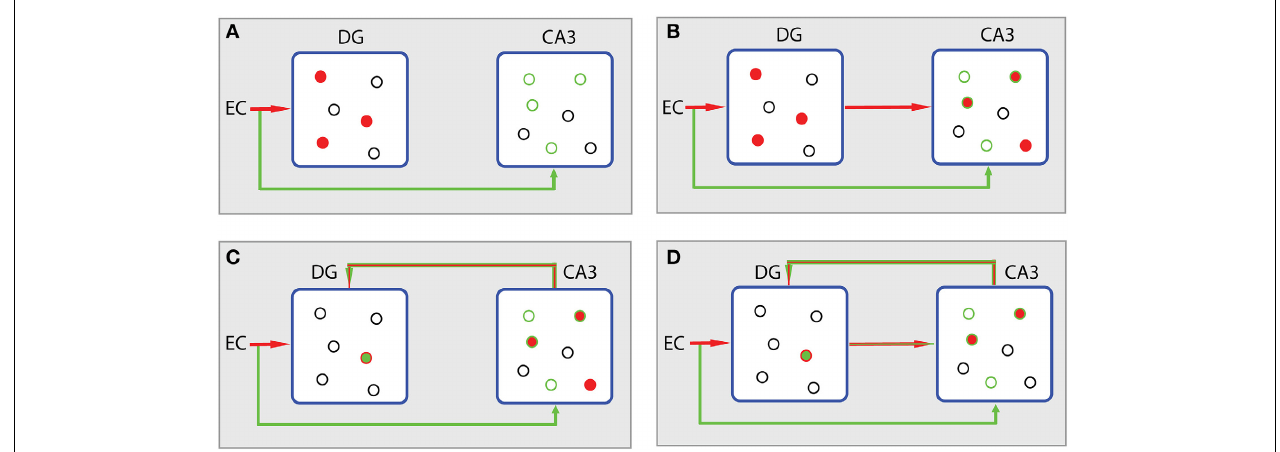
FIGURE 5 | Processing scheme in hippocampus according to the CS theory. (A) The EC input causes the firing of a population of granule cells in DG (filled red cycles) and a subthreshold depolarization of a subset of CA3 pyramidal cells (empty green cycles). Source of excitation and corresponding activity are depicted with the same colors. Excited cells are depicted by filled cycles. Colored empty cycles represent near-thershold cells, which are depolarized but not active. Black cycles represent cells at rest. (B) In CA3, excited cells, the ones excited after the subthreshold depolarization and the ones directly excited by mossy fibers (filled red cycles in CA3), constitute the